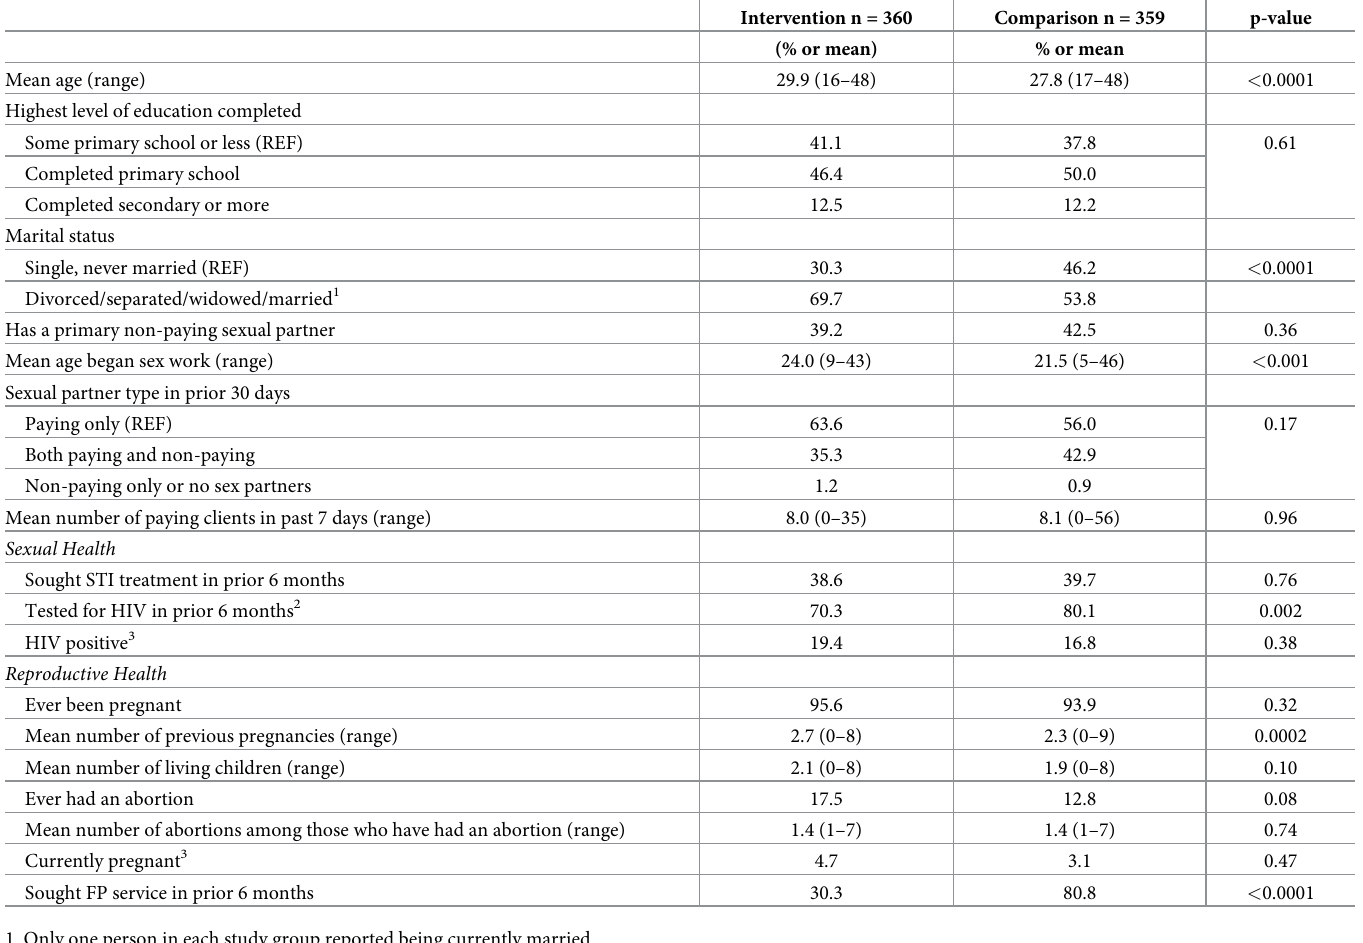
Table 1. Selected background characteristics of FSWs at baseline by study group. Student t-test used for continuous variables; Chi-square test used for categorical vari- ables (non-imputed